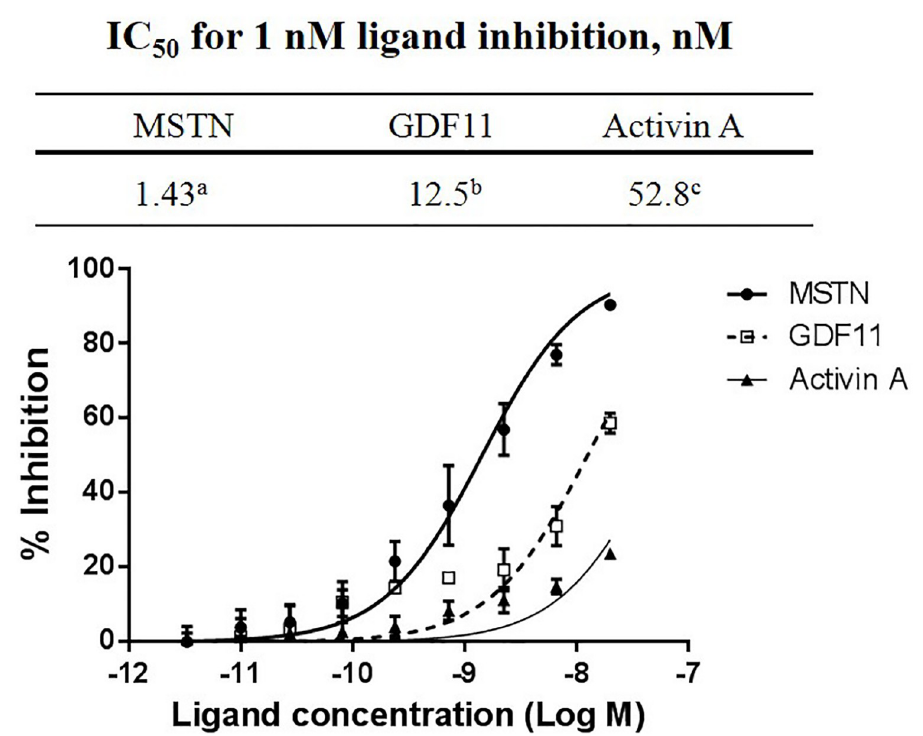
Fig 1. MBP-Pro45-70-His6 inhibits MSTN activity at much lower concentration than those required to inhibit GDF11 or Activin A activities. Various concentrations (20, 6.67, 2.22, and 0.73 nM) of MBP-Pro45-70-His6 in combination with 1 nM MSTN, GDF11, or Activin A in serum-free DMEM were added to the HEK293 cells stably expressing (CAGA) 12 -luciferase gene construct, followed by incubation for 24 h. Luciferase activity was measured using Bright-Glo luciferase assay system (Promega, USA). The error bars indicate standard deviation (n = 3). Percentage of inhibition capacity = (luminescence at ligands (1 nM MSTN, GDF11, or Activin A)–luminescence at each MBP-Pro45-70-His6 concentration) × 100/(luminescence at ligands (1 nM MSTN, GDF11, or Activin A)– luminescence at 0 nM ligands. IC 50 (ligand concentration inhibiting 50% of MSTN, GDF11 or Activin A activity) values were estimated by a non-linear regression model defining the dose-response curve. IC 50 values not sharing the same superscript are different at P <